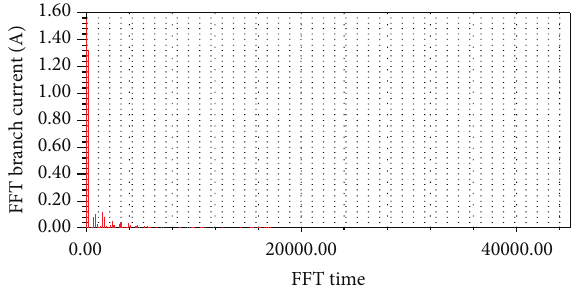
Figure 31: The FFT of DC link current in hysteresis control mode (with LCL filter and capacitor